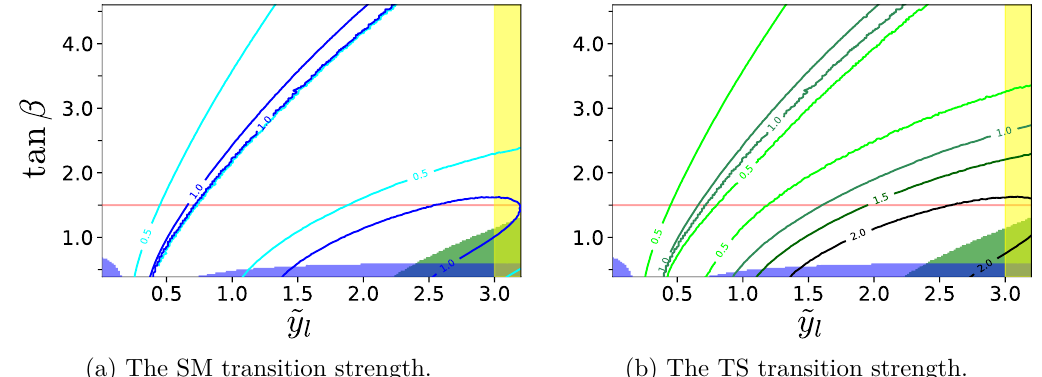
Figure 5. The phase transition strength ∆ v I ( T c ) /T c versus twin lepton Yukawa coupling ˜ y l in SUSY TH model with light sleptons for tan β = 2 . The blue and cyan lines correspond to the scenario with enhanced ˜ y l for only one family of twin leptons, while the pink and red lines correspond to Yukawa couplings of all three twin leptons set to ˜ y l . The cyan and pink lines denote the results for right-handed sleptons only, wheres the red and blue lines correspond to the scenario with both slepton chiralities. Solid lines denote the results with ˆ µ = 90 GeV while dashed lines for those R (L) with ˆ µ = 290 GeV. R (L)